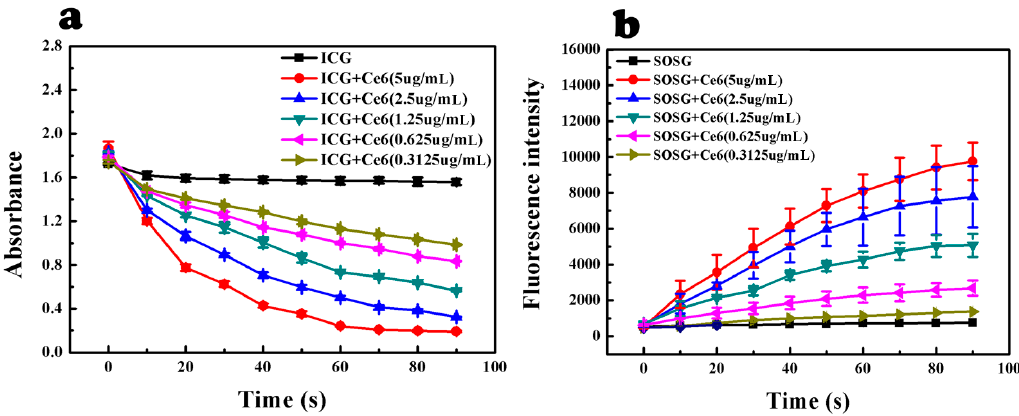
Figure 2. Sensitivity of ICG to 1 O 2 produced by Ce6. ( a ) UV absorbance of ICG with Ce6 after each 10-s laser irradiation (nine times in total); ( b ) fluorescence intensity of SOSG with Ce6 after each 10-s laser irradiation (nine times in total). (Mean ± SD, n = 3)